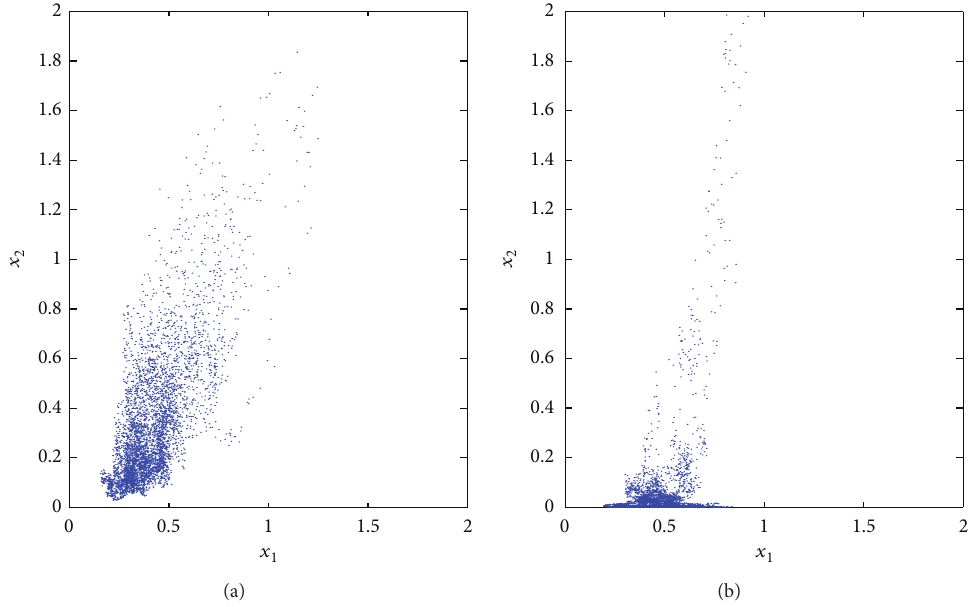
Figure 6: Population distribution of stochastic system (73); 𝜎 1 = 0.2 , 𝜎 2 = 0.8 , 𝑑 12 = 0.6 , and 𝑑 21 = 0.5 in the left subgraph (a) and 𝜎 1 = 0.2 , = 0.8 , 𝑑 = 0.01 , and 𝑑 = 0 in the right subgraph 𝜎 2 12 21